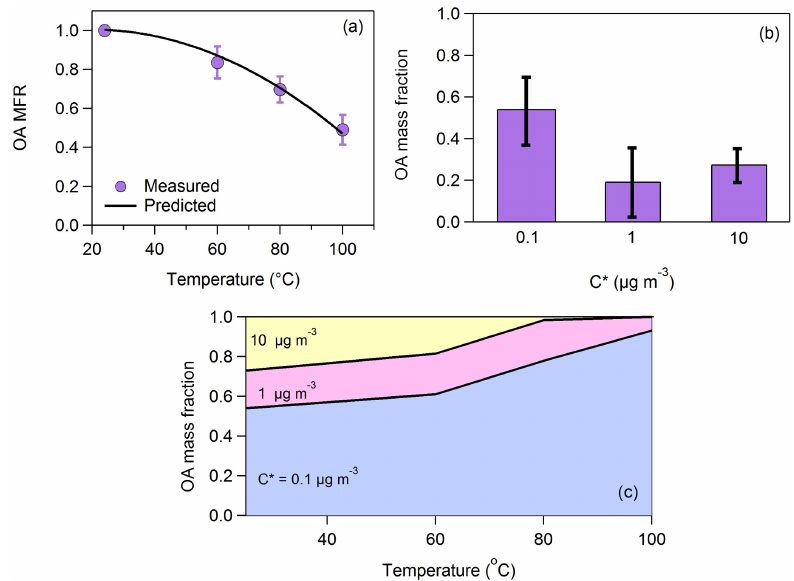
Figure 1. (a) Loss-corrected MFR of the total OA. The purple circles correspond to the measurements and the uncertainties to 1 standard deviation of the mean. It is assumed that MFR = 1 at T = 24 ◦ C. The black line is the model fit estimated using the approach of Karnezi et al. (2014). (b) The total OA volatility distribution. The uncertainties have been estimated according to the algorithm of Karnezi et al. (2014). (c) The predicted volatility distribution after passing through the thermodenuder as a function of the temperature.